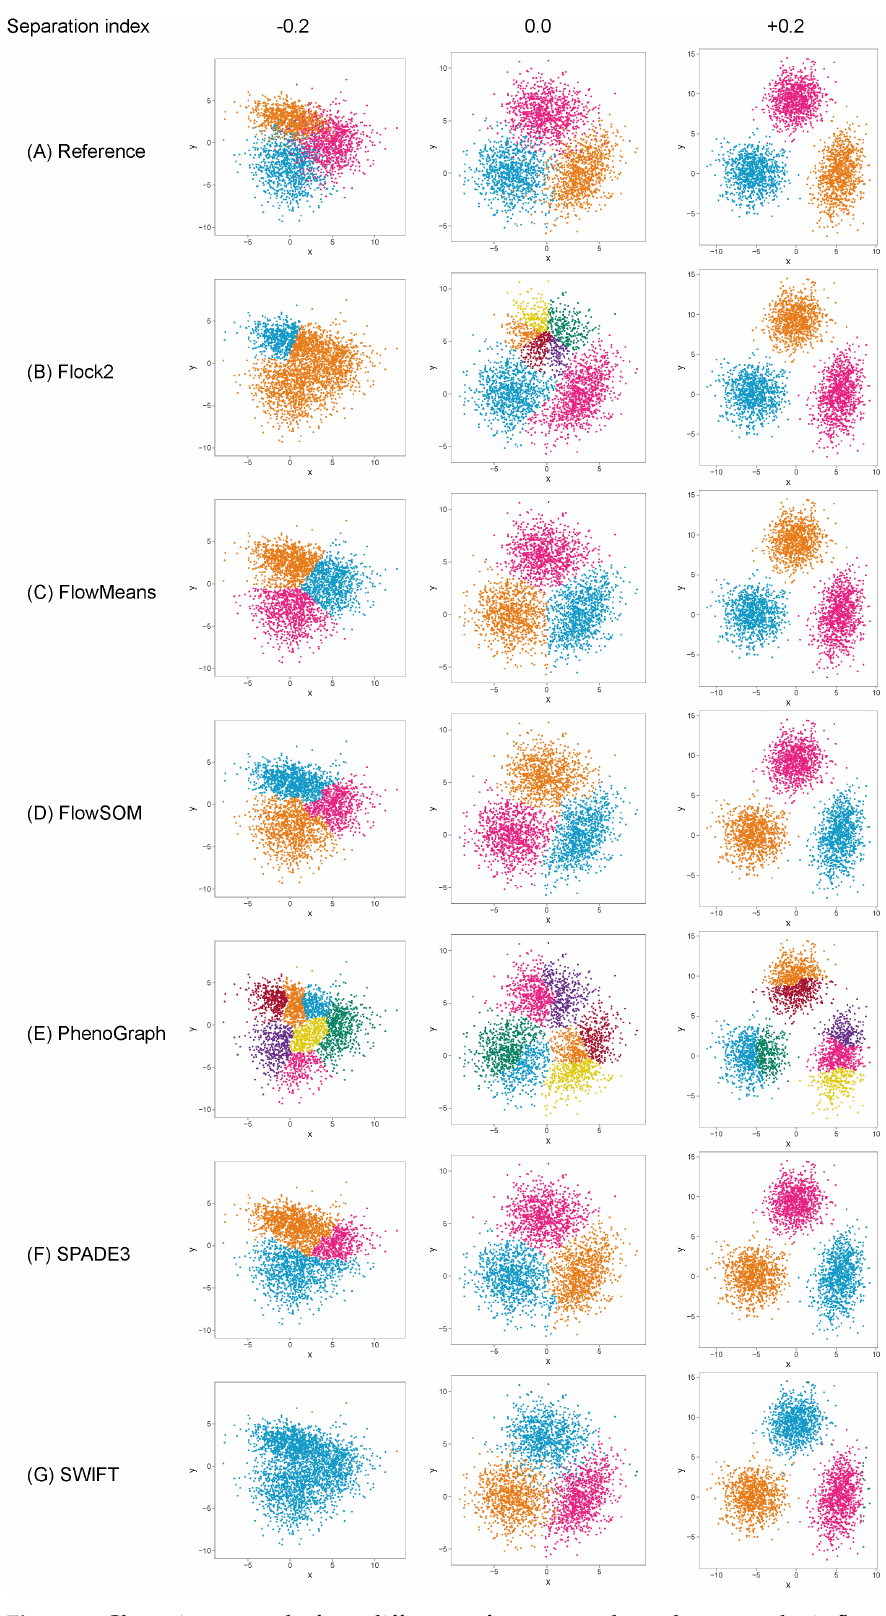
Figure 3. Clustering examplesfrom different software on a three-cluster synthetic flow cytometry dataset with different degrees of separation between